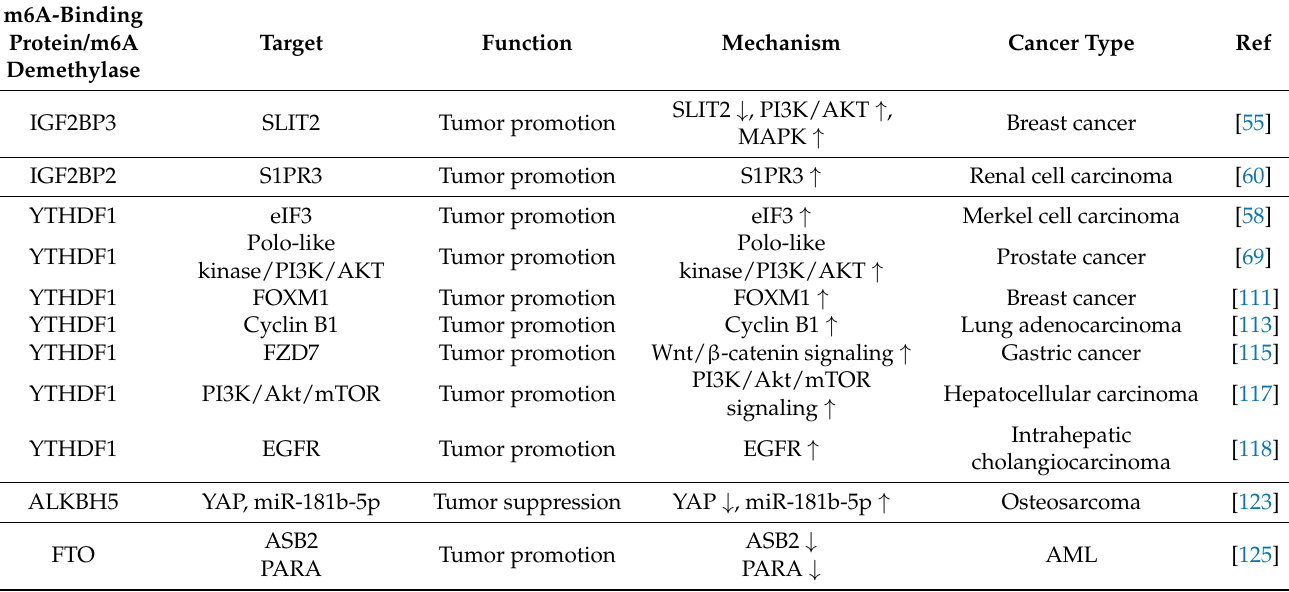
Table 3. Roles and targets of m6A-binding proteins and m6A demethylases in